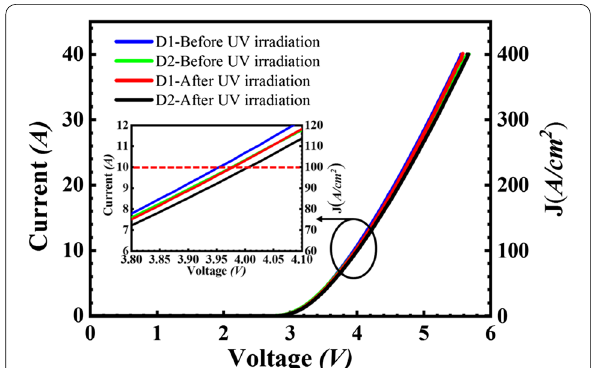
Fig. 2 Forward on state characteristic of 4H-SiC PiN diode before and after UV